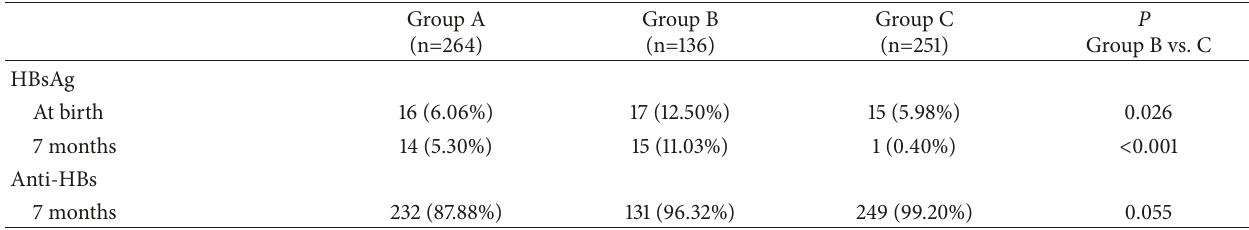
Table 4: HBsAg and anti-HBs status of the